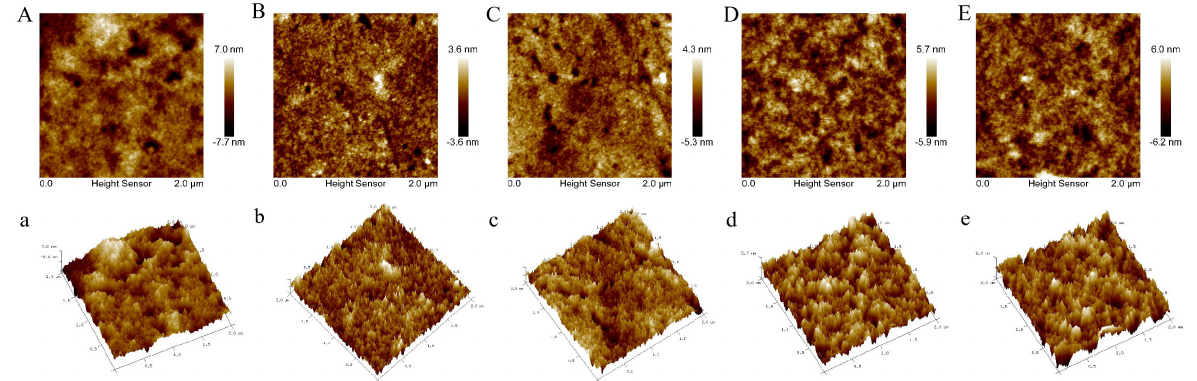
Figure 3. The 2D and 3D AFM images of MP in peeled shrimp soaked with fresh water, sodium tripolyphosphate, trehalose, and phosphorylated trehalose after 12 weeks of frozen stor- age. ( A , a ): fresh shrimp muscle tissue (0 d); ( B , b ): shrimp muscle tissue treated with fresh water; ( C , c ): shrimp muscle tissue treated with sodium tripolyphosphate; ( D , d ): shrimp muscle tissue treated with trehalose; ( E , e ): shrimp muscle tissue treated with phosphorylated